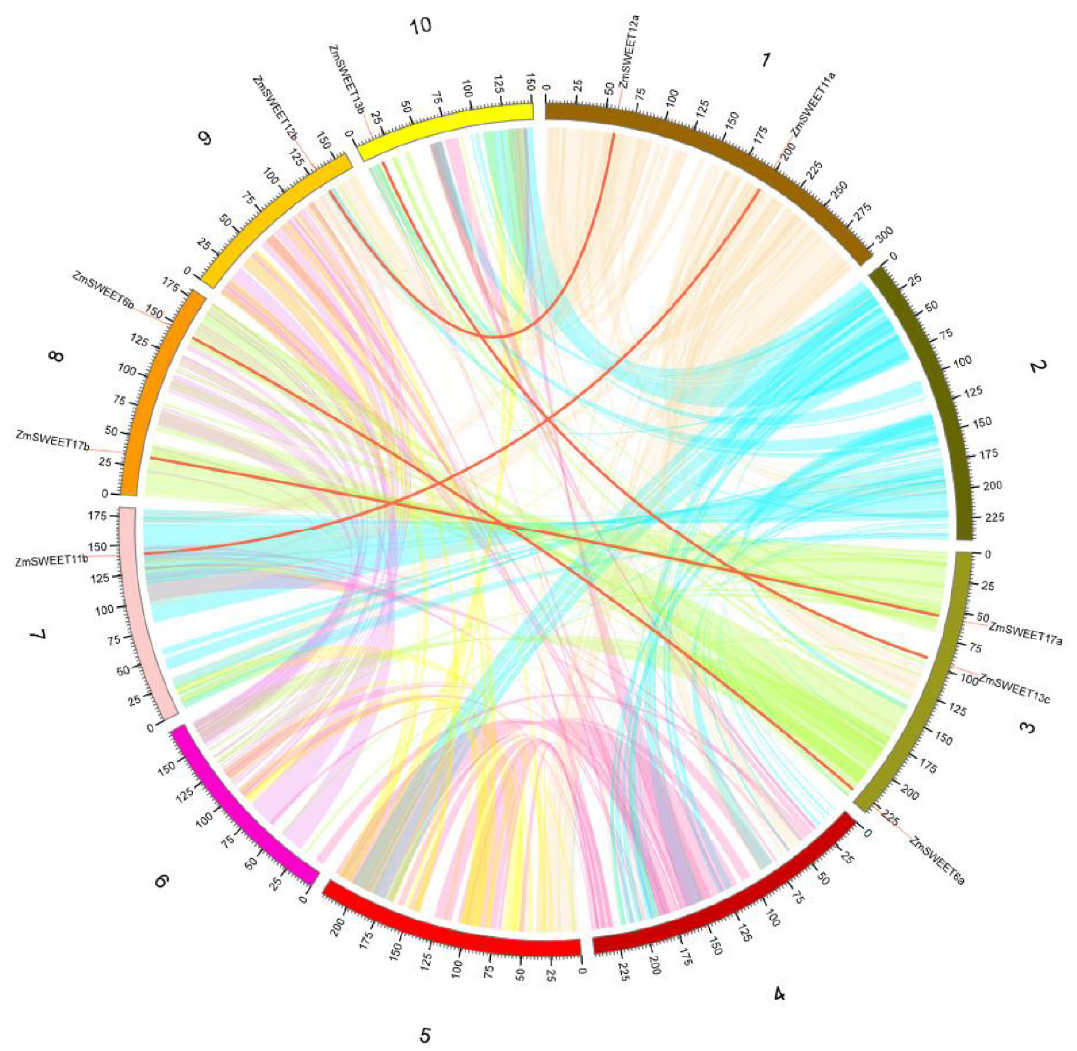
Figure 3. Synteny analysis of the SWEET family in maize. Red curves linking ZmSWEET genes in- dicate duplicated gene pairs in the maize SWEET